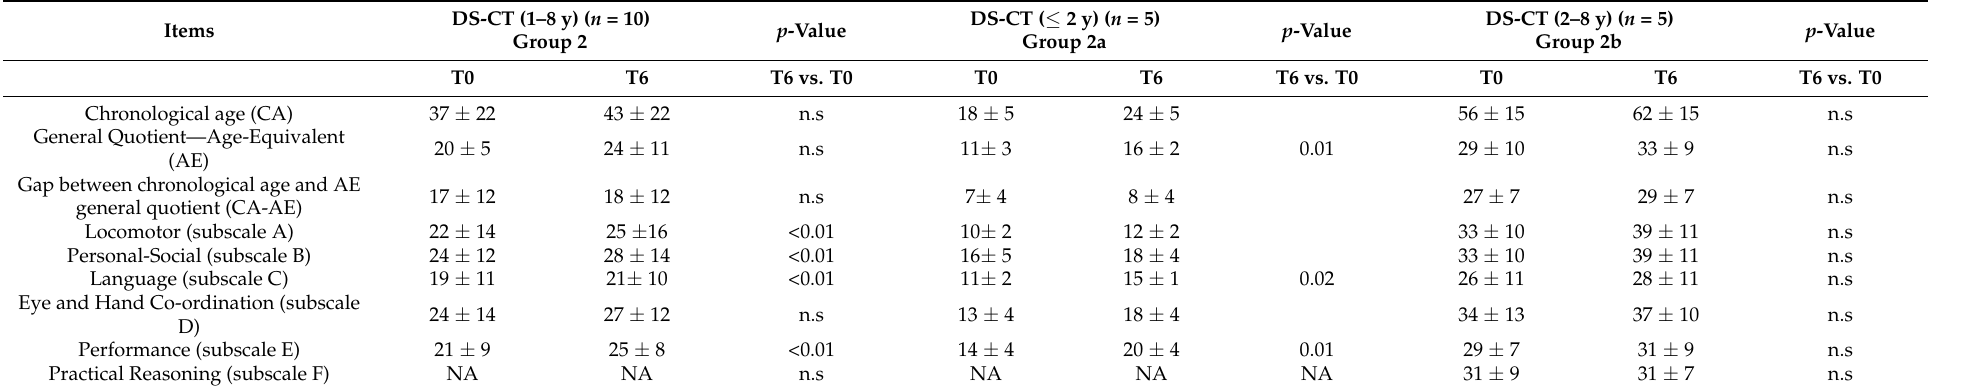
Table 5. Results of the GMDS-ER analysis in untreated DS control